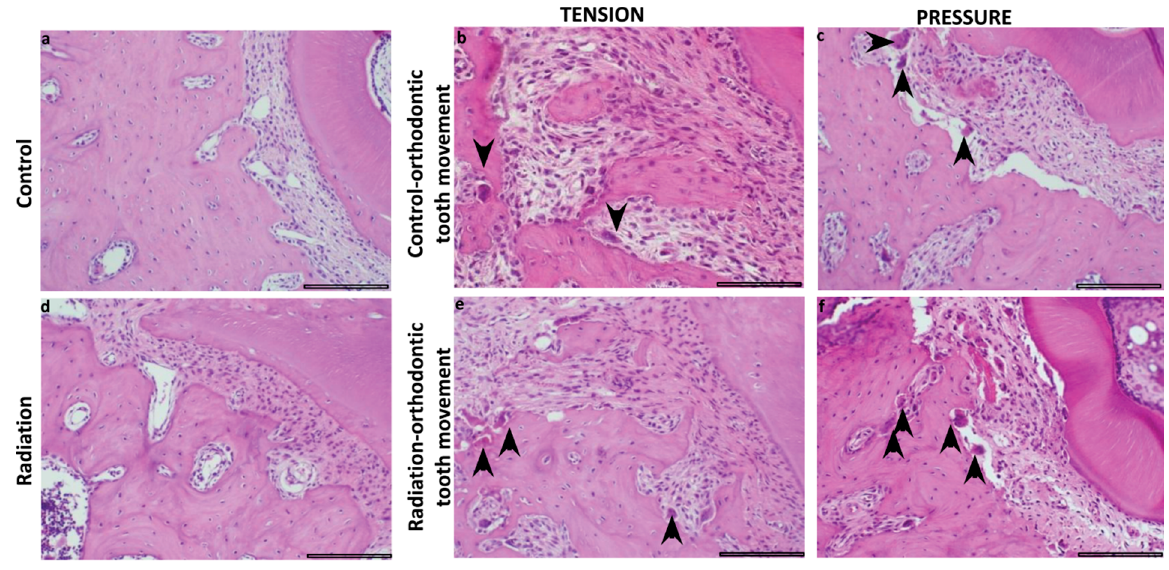
Figure 4. Representative sections showing multi-nucleated osteoclastic cells (arrows) as a factor of study group and tension/pressure sides (hematoxylin and eosin, scalebar 50 μ ): ( a – c ) control group, ( d – f ) irradiated group. Note the increased number of osteoclastic cells in the pressure side in both groups.